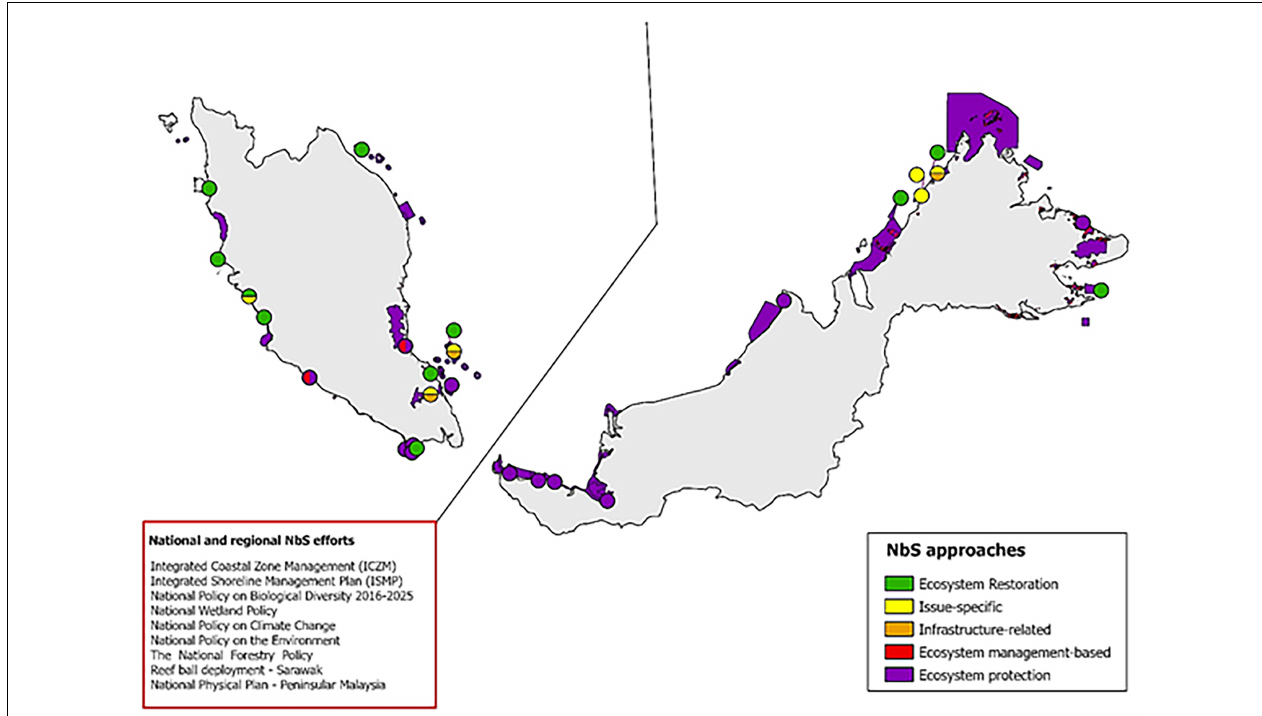
FIGURE 3 | NbS efforts in Malaysia. Efforts are color coded and may embody a combination of approaches. Area-based protection approaches include IBAs, MPAs, marine parks, national parks, state parks, forest reserves, turtle sanctuaries, wildlife reserves, and Ramsar sites; these are predominantly ecosystem protection mechanisms, but some, such as Forest Reserves (illustrated here in red and purple hatch), also have an ecosystem management component. National and regional ecosystem management-based interventions are inset (red border). Points and polygons with multiple colors embody multiple NbS approach